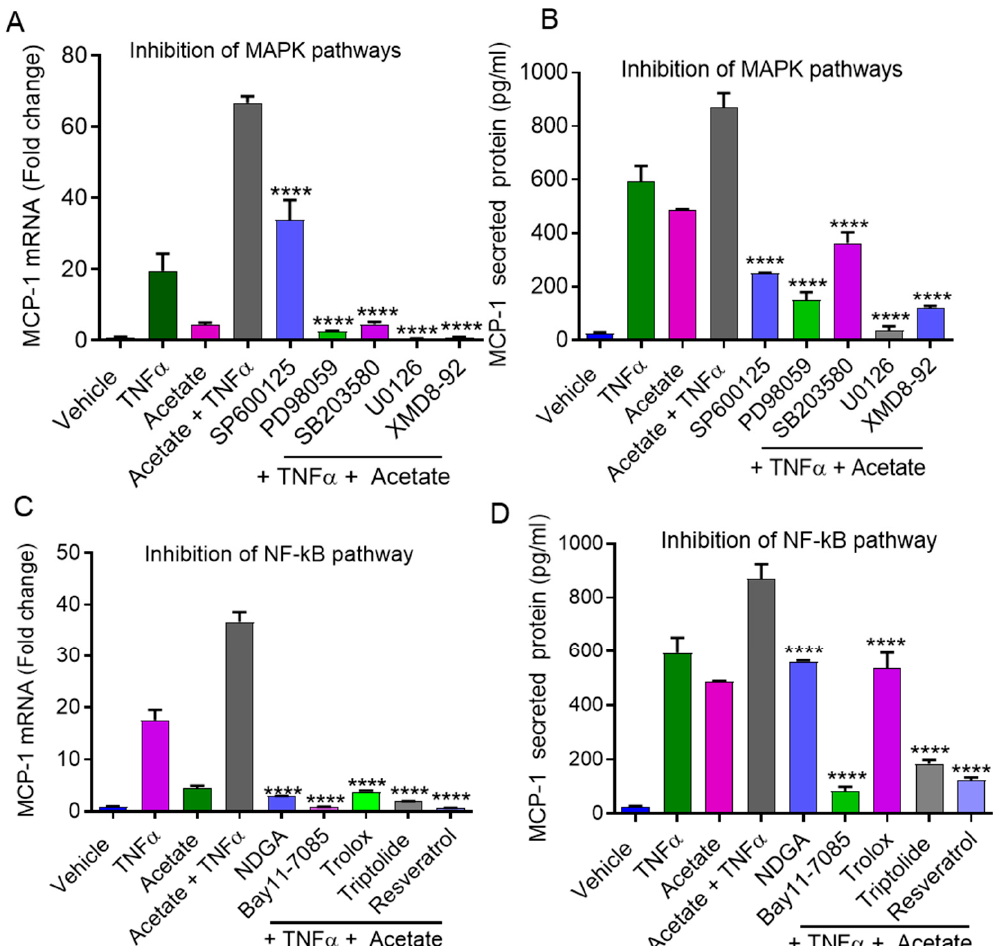
Figure 6. Effect of MAPK and NF-kB pathways inhibitors on MCP-1 induction by acetate/TNF α . THP-1 monocytic cells were pretreated with JNK inhibitor (SP600125: 20 uM) or MEK-ERK inhibitors (PD98059: 10 uM; U0126: 10 uM: XMD-92: 5 uM) or p38 inhibitor (SB203580: 10 uM) for 1 h and then treated with acetate/TNF α for 24 h. Cells and supernatants were collected. ( A ) Cells were used for the isolation of total RNA to assess the MCP-1 gene expression by real-time RT-PCR. ( B ) Secreted levels of MCP-1 protein were determined in supernatants by ELISA. THP-1 cells were pretreated with NF- κ B inhibitors (NDGA, 30 uM; Bay11-7085, 10 uM; Trolox, 10 µ M; Triptolide, 10 µ M; Resveratrol, 15 uM) for 1 h and then treated with acetate (100 mM)/TNF α (10 ng/mL) for 24 h. ( C , D ) MCP-1 was determined by RT-PCR and ELISA. The results obtained from three independent experiments are shown. The data are presented as mean ± SEM (n = 3). **** p < 0.0001.